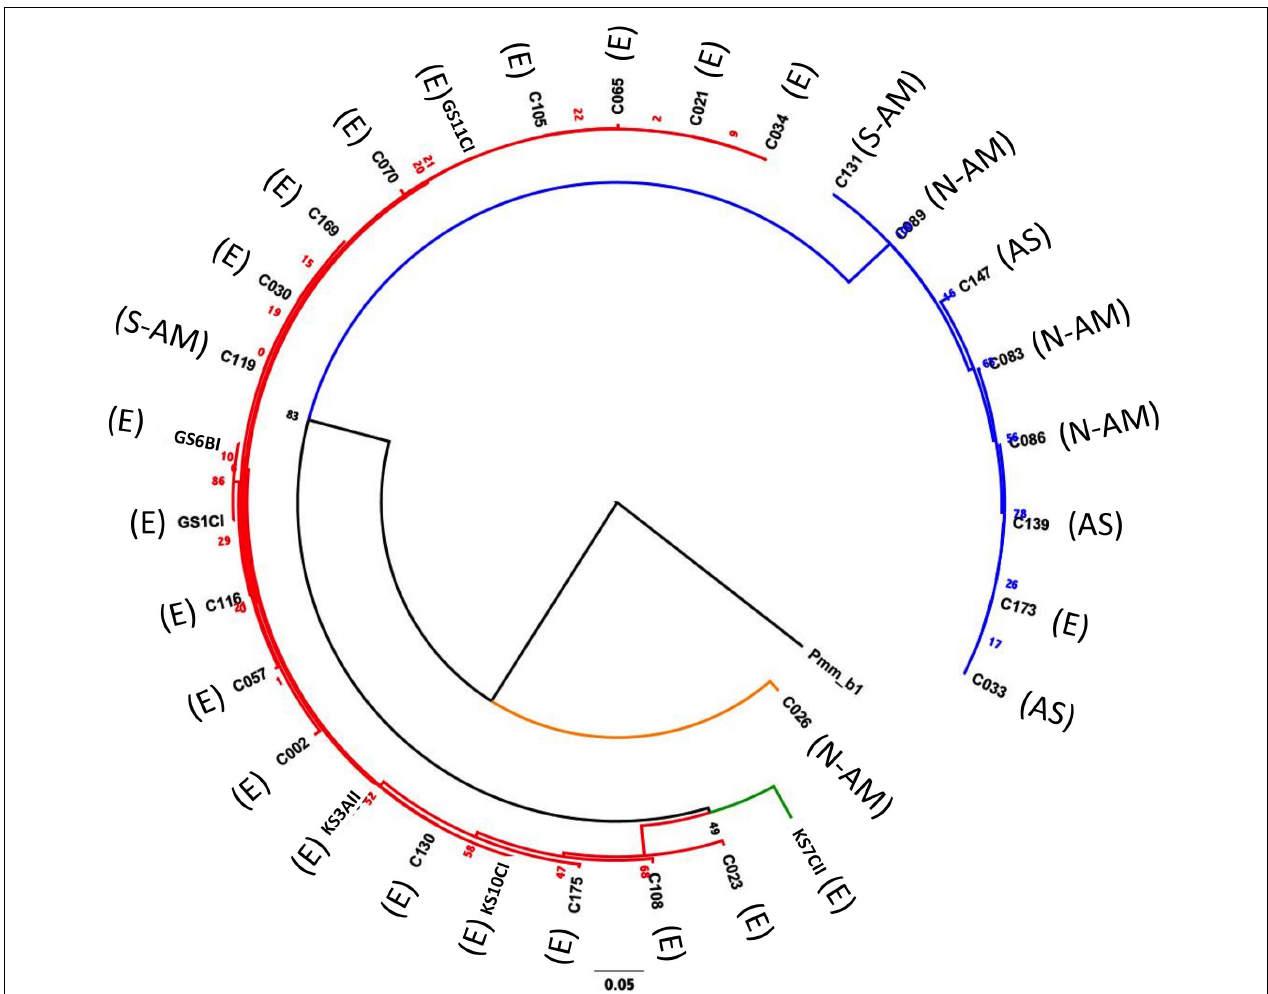
FIGURE 2 | Maximum likelihood phylogeny (Tamura-Nei substitution model) constructed by comparing the COI sequence (626 nts) of the 30 Paramecium caudatum strains used in this study, using for an outgroup a Paramecium multimicronucleatum isolate PmCOI_b1_01 (accession number AM072765.1) (Barth et al., 2006). Red branches = haplogroup A; blue branches = haplogroup B; orange branches = haplogroup C; green branches = haplogroup D. Geographic origins are as follows: E = European origin; AS = Asia; N-AM = North America; S-AM = South America. The number represent maximum likelihood estimates of branch lengths (mean number of substitutions per site).